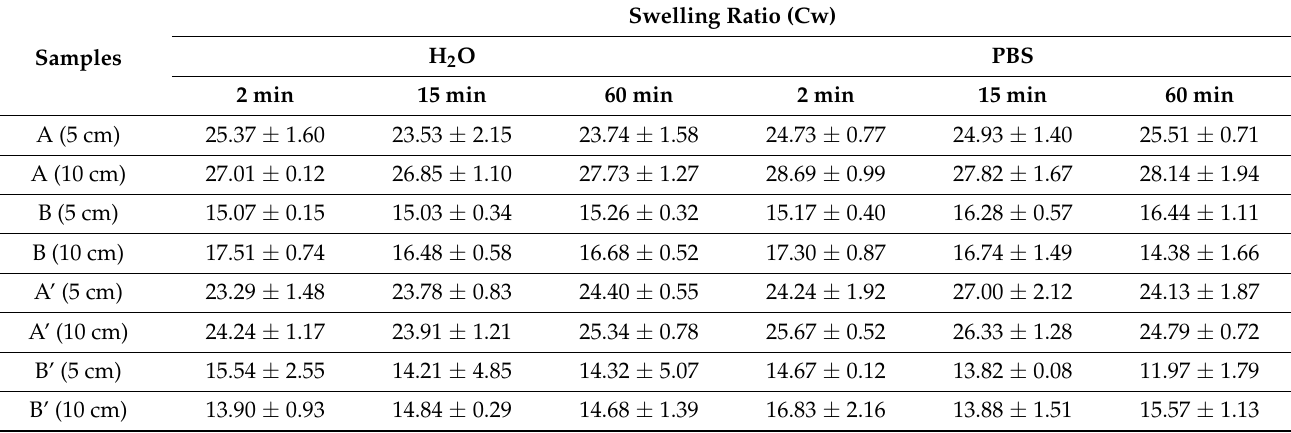
Table 1. Swelling kinetics of the collagen/nanoHA scaffolds before and after sterilization (A, B, A’, and B’) with different sizes in PBS buffer and distilled